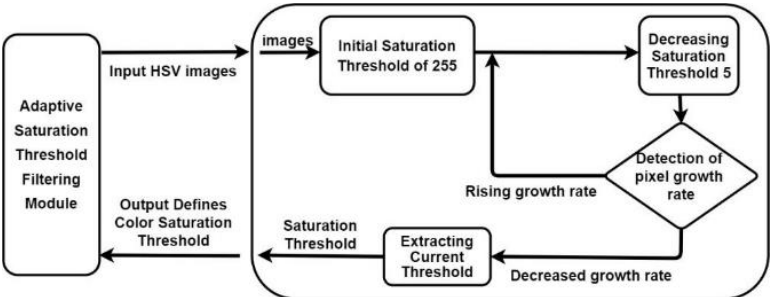
Figure 39. Developed module for adaptive saturation threshold filtering.